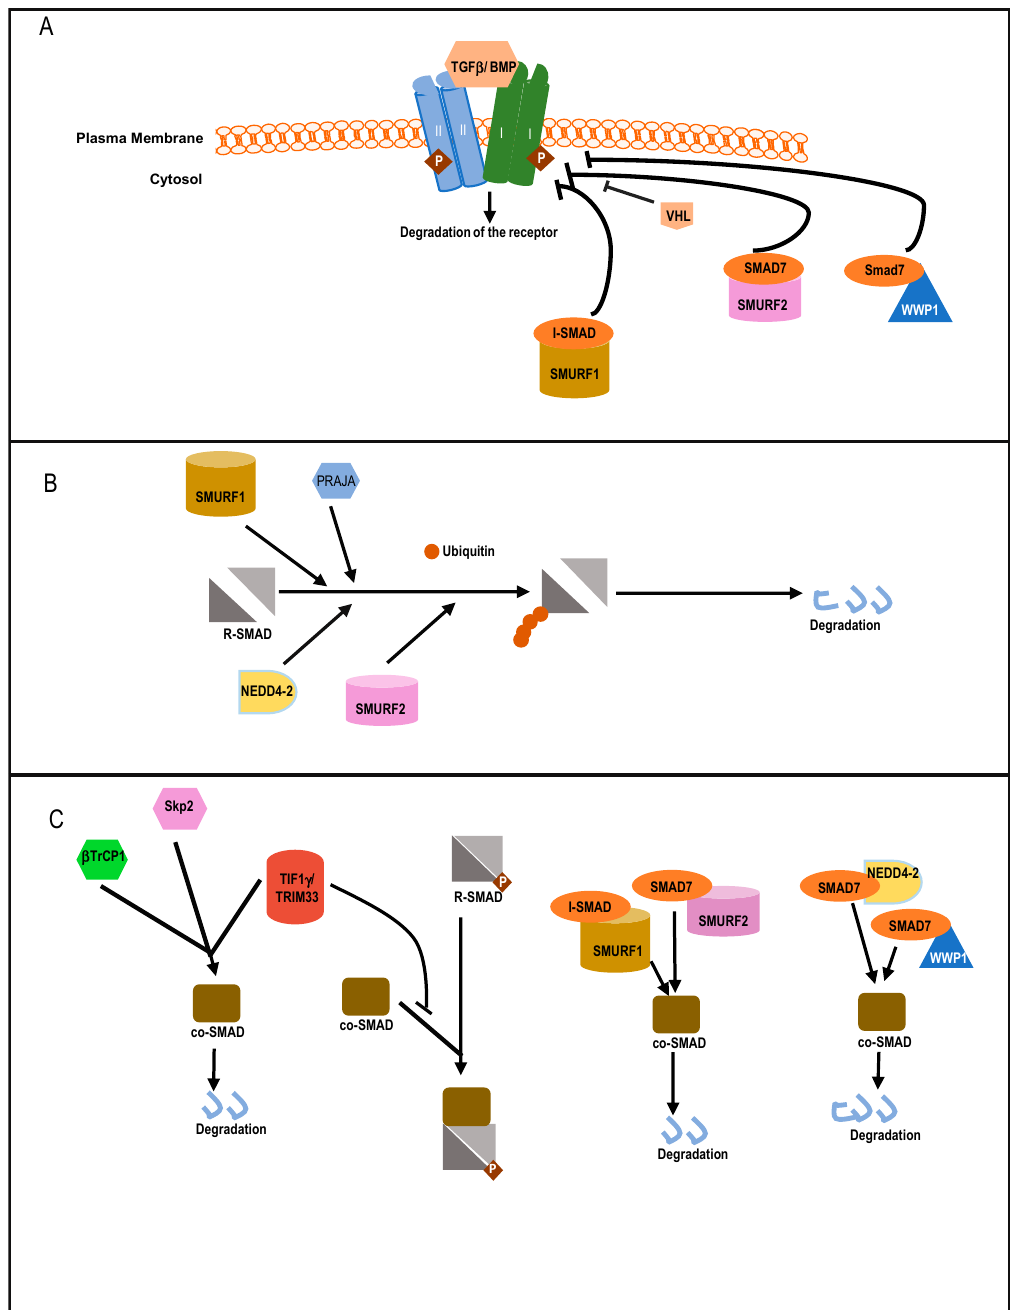
Figure 4. Schematic representation of negative regulation of TGF β signaling with major E3 ubiquitin ligases. ( A ) Direct inhibition of T β RI by different E3 ligases. SMURF2, WWP1 interact with SMAD7 to inhibit T β RI but SMURF1 can combine with either I-SMADs (SMAD6 or SMAD7) to inhibit T β RI. These E3 ligases induce K-48 mediated polyubiquitination of the receptor, which ultimately induces degradation. ( B ) Inhibition of R-SMAD phosphorylation and stability by diverse E3 ligases. SMURF1 is specific for BMP SMADs (SMAD1/5). PRAJA and NEDD4-2 induce K-48 linked polyubiquitination of SMAD3 and SMAD2, respectively. SMURF2 can ubiquitinate (K-48 linked) R-SMADs (SMAD 1/2 and SMAD3). ( C ) Inhibition and degradation of co-SMAD by different E3 ligases and the role of I-SMADs in this process. SKP2 specifically targets mutant co-SMAD for ubiquitination.